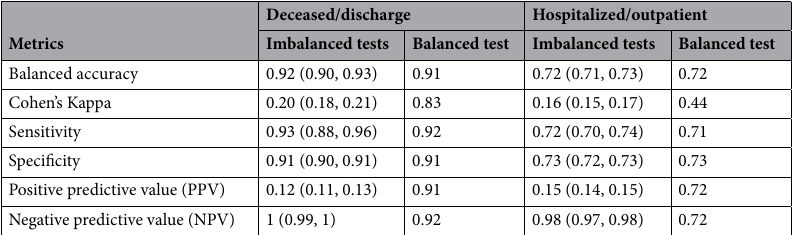
Table 3. Metrics obtained in the test dataset using the best training model. Balanced tests are sets with the same number of patients of each class. Imbalanced tests are sets with the same proportion of classes as the original dataset, where the number of examples for each class label is not balanced. Those sets are made up by a chosen number of samples of patients for each class. For imbalanced tests we report the mean (95% CIs) of each metric, and for balanced tests we report the value of each metric.